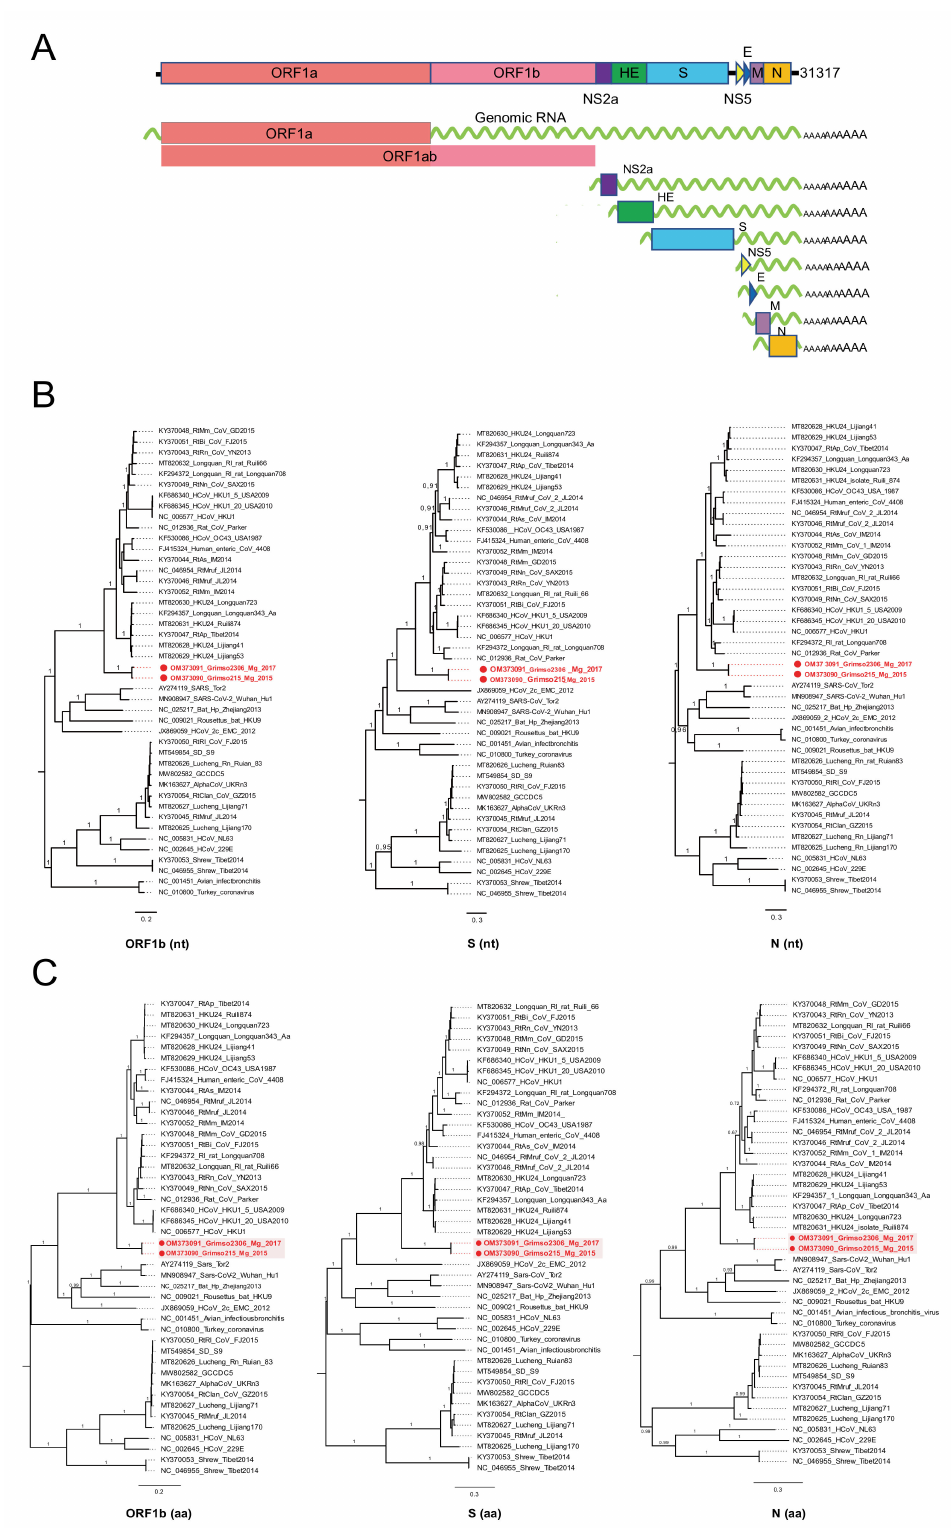
Figure 2. ( A ) Genomic RNA and subgenomic mRNAs organizations of Grimso virus, Grimso215 strain. MrBayes trees based on the complete nucleotide sequences ( B ) and amino acid sequences ( C ) of ORF1b, S, and N genes of CoVs. The red color shows Grimso virus. The scale bar indicates the nt and aa substitution per site, respectively. The numbers above the branches indicate the posterior